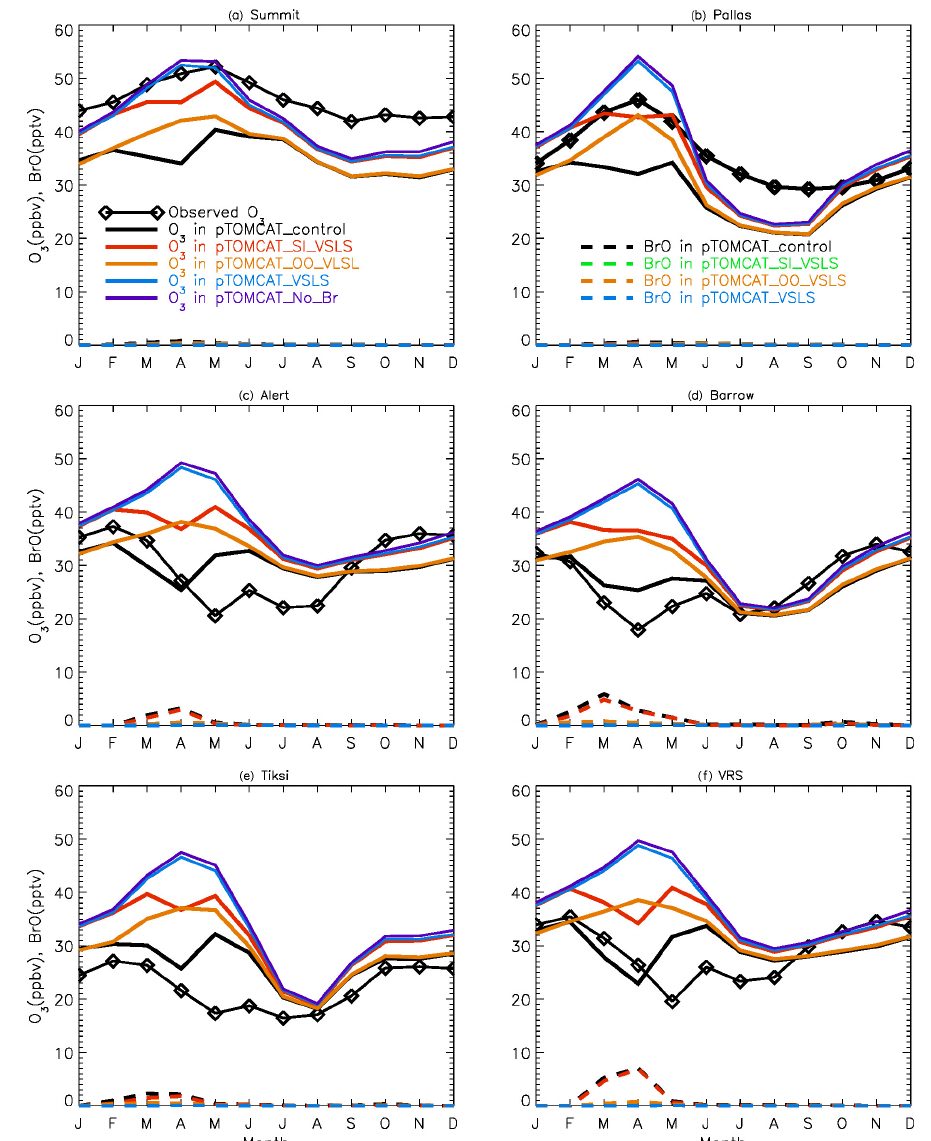
Figure 2. Climatology of monthly mean surface ozone (solid black line with diamond symbols) at six Arctic sites. The observed data are the average of 2000–2016 at Summit, 1995–2012 at Pallas, 1992–2012 at Alert, 1974–2016 at Barrow, 2011–2016 at Tiksi, and 1980–2014 at VRS. Model surface ozone concentrations (VMRs) from various experiments are shown in colourful solid lines with BrO in dashed lines based on an integration of